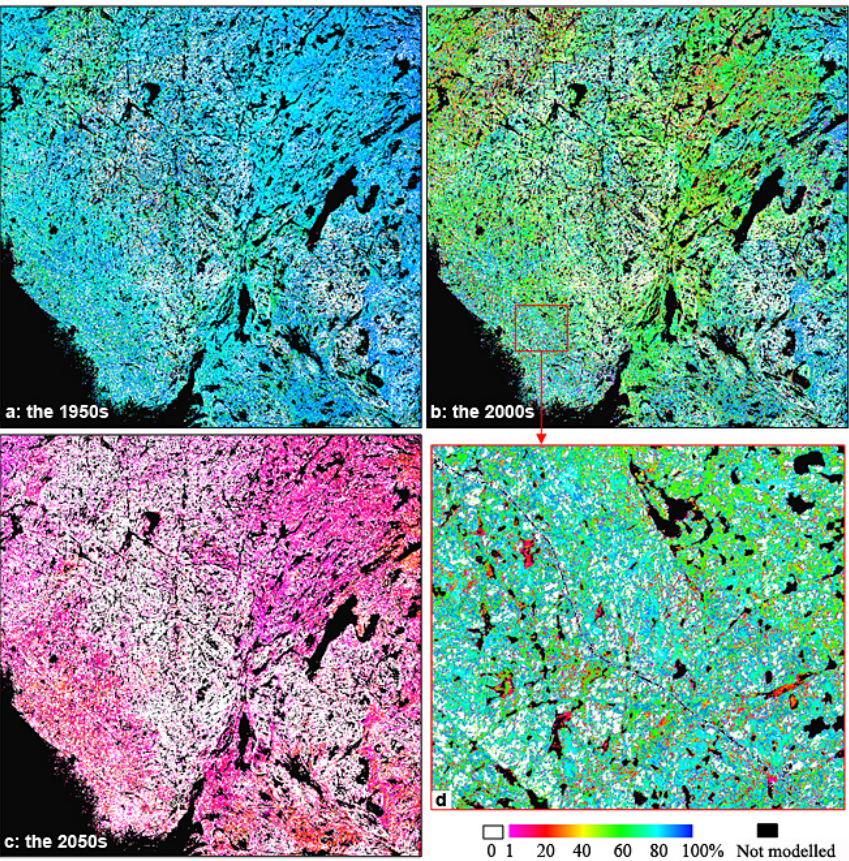
Figure 5. Modelled permafrost probability distributions in the 1950s, 2000s, and 2050s ( a , b , and c , respectively). (d) shows an enlarged area in (b)